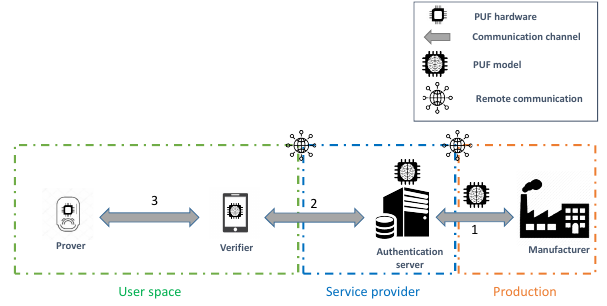
Figure 8. Four-component enrollment